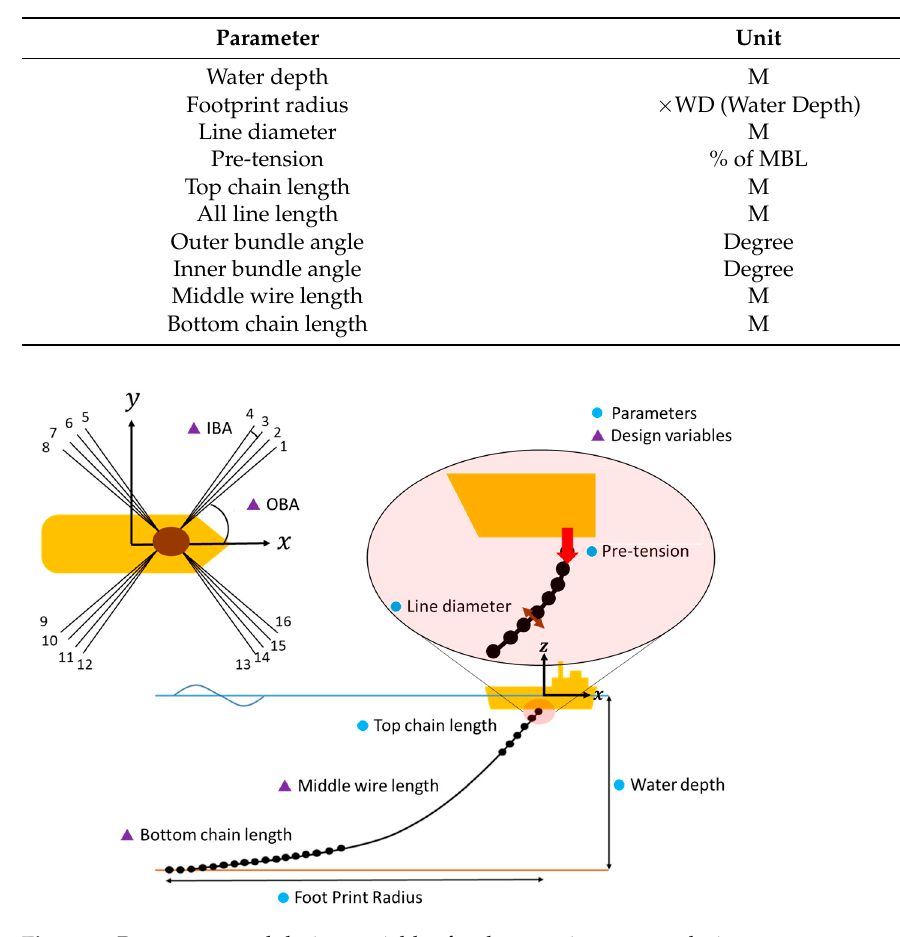
Table 1. Factors for the mooring system design.